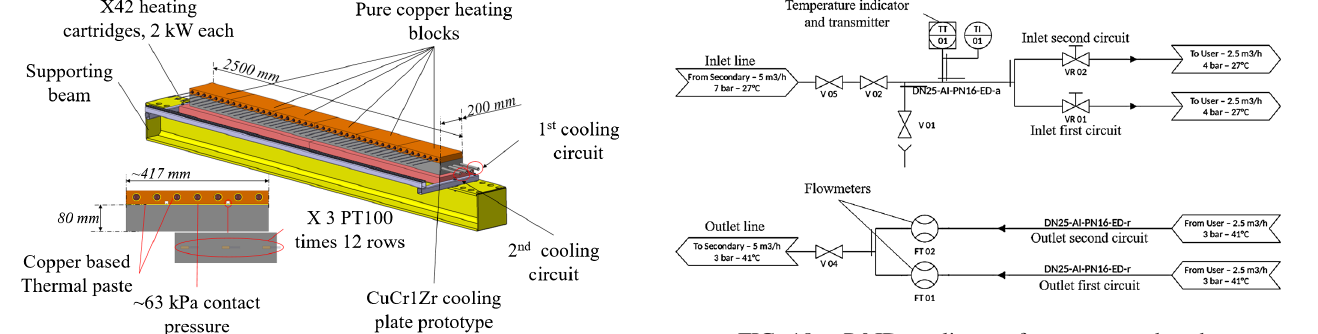
FIG. 18. P&ID cooling performance test bench.